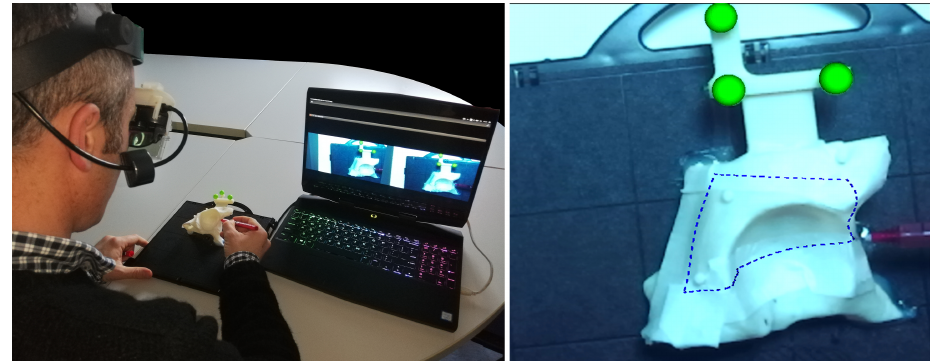
Figure 3. On the left: subject during a T3 task. On the right: AR scene visualized by the subject. The subject was asked to perform the “trajectory tracing” task three times for each trajectory, and to report any perceptible spatial jitter or drift from the AR content. The trajectories were administered in random